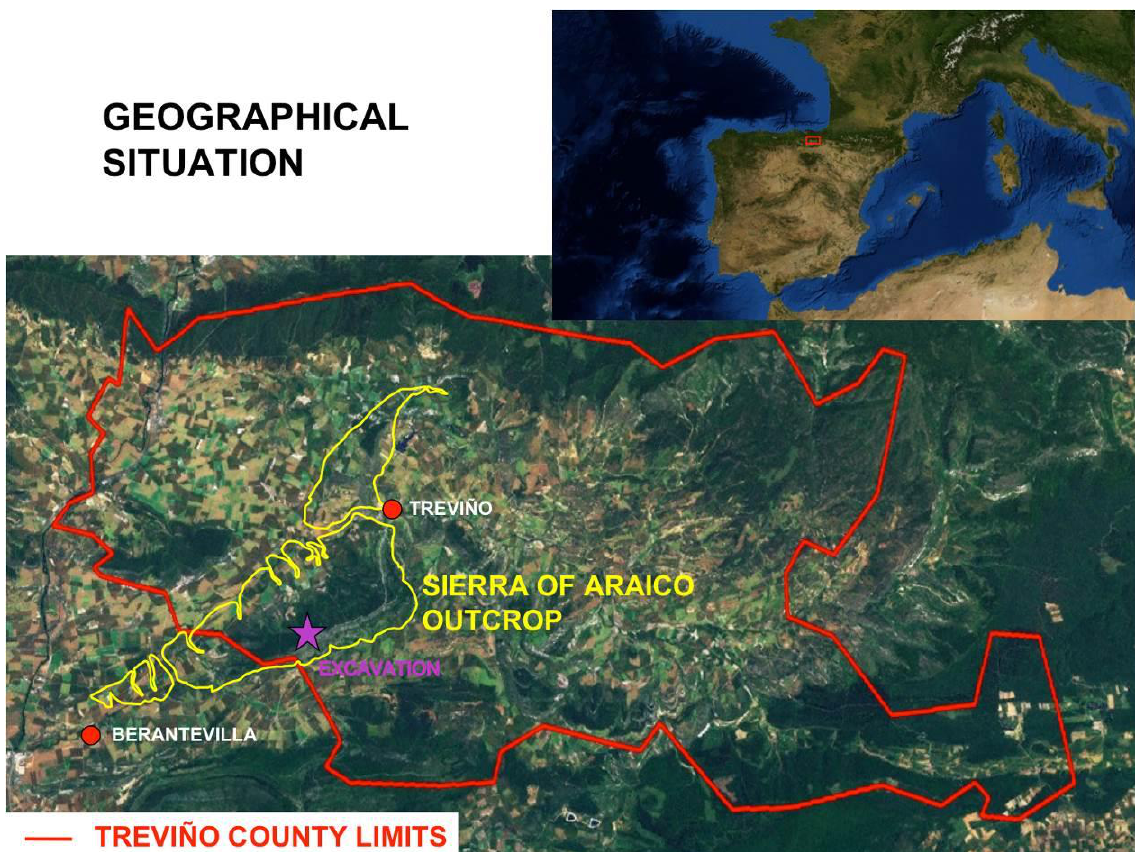
Figure 1. Localization of the outcrops of the carbonated unit that contain the flint and the spot where the excavation was